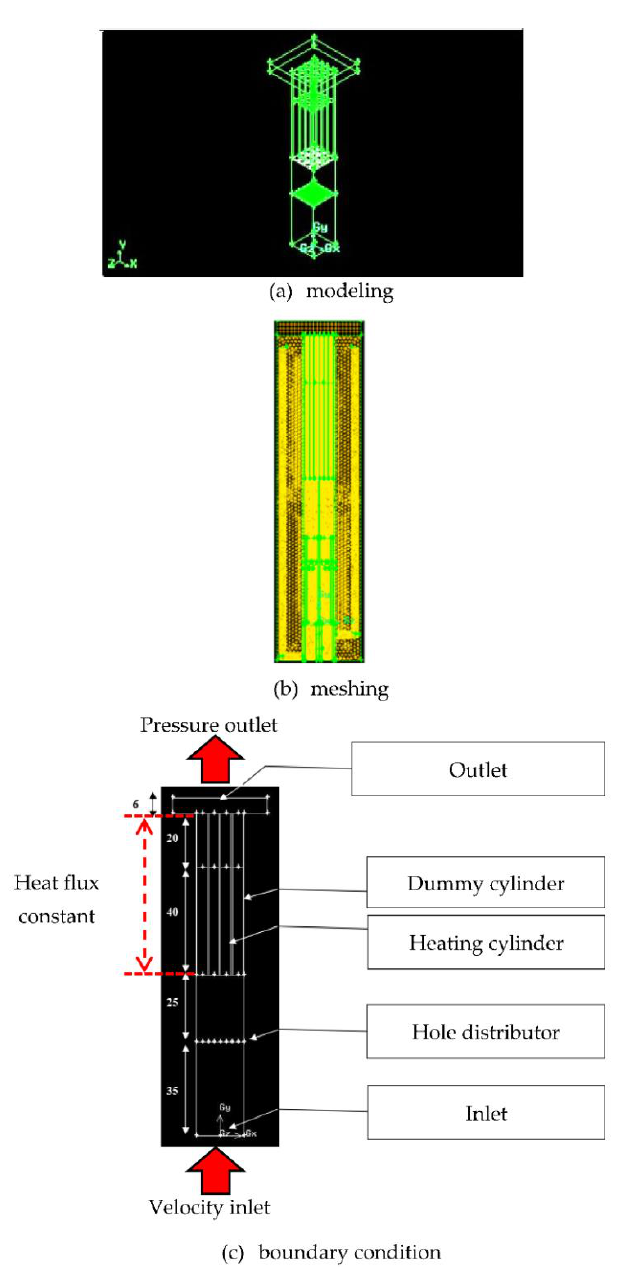
Figure 3. Modeling, meshing, and boundary conditions of sub-channel vertical square.